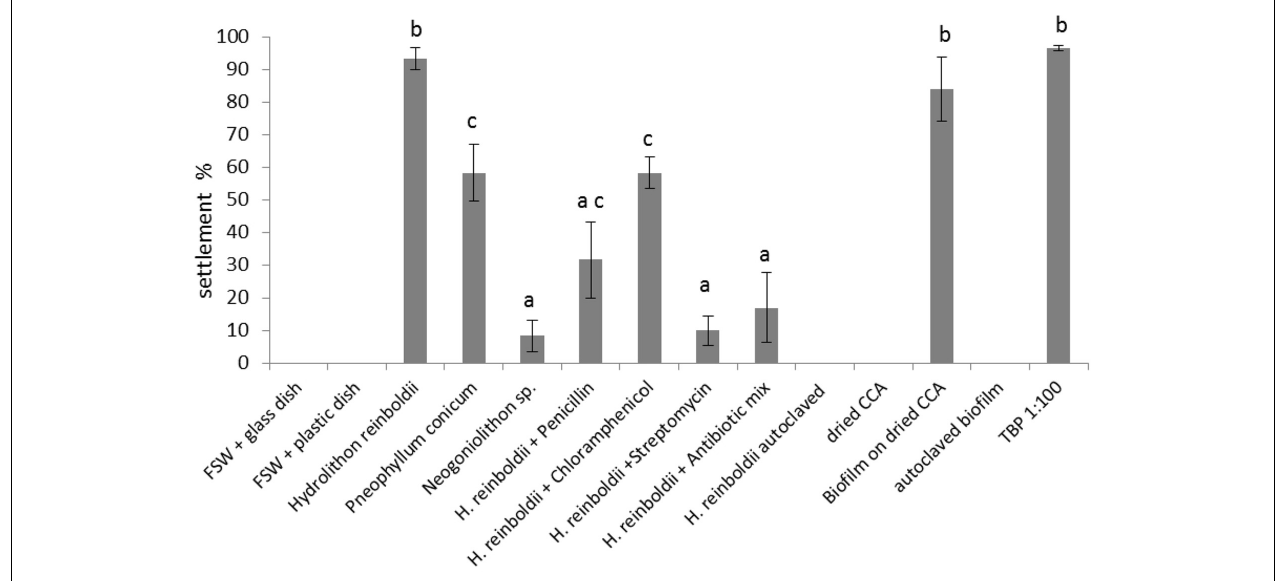
FIGURE 8 | Larval settlement in response to different substrates ( n = 6). Error bars represent standard error (SE). Letters represent groups that differed significantly in Tukey’s Test (significance level p <